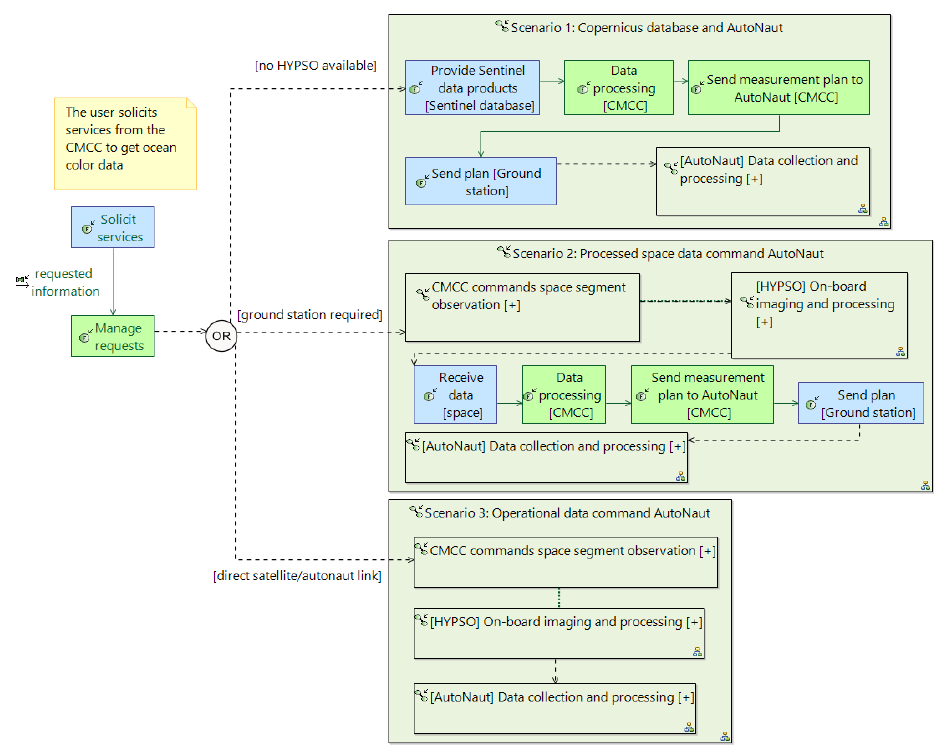
Figure 5. Information flow in the different scenarios is shown as functional chains. Dashed lines signify sequenced exchanges, while solid lines signify functional exchanges. The blue boxes represent functions allocated to actors, and green boxes represent functions allocated to the system-of-interest (here, the CMCC). The [+] indicates that an element can be expanded but was not in this diagram to maintain the high-level perspective and